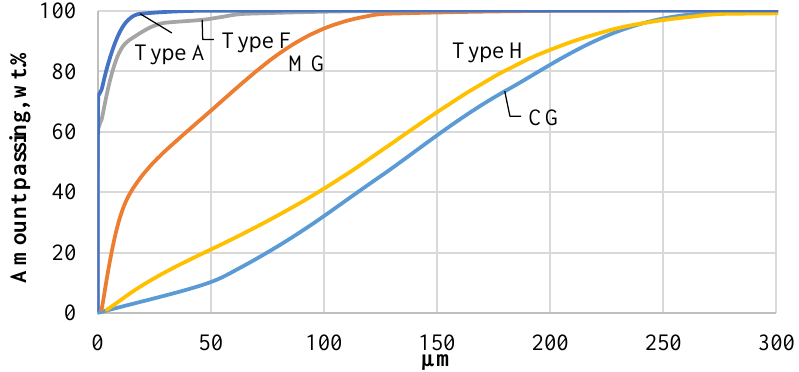
Figure 5. Particle size distribution of different types of gypsum CDW determined by laser diffrac- tion analysis: Type A—white standard plasterboard; Type H—Impregnated gypsum plasterboard;